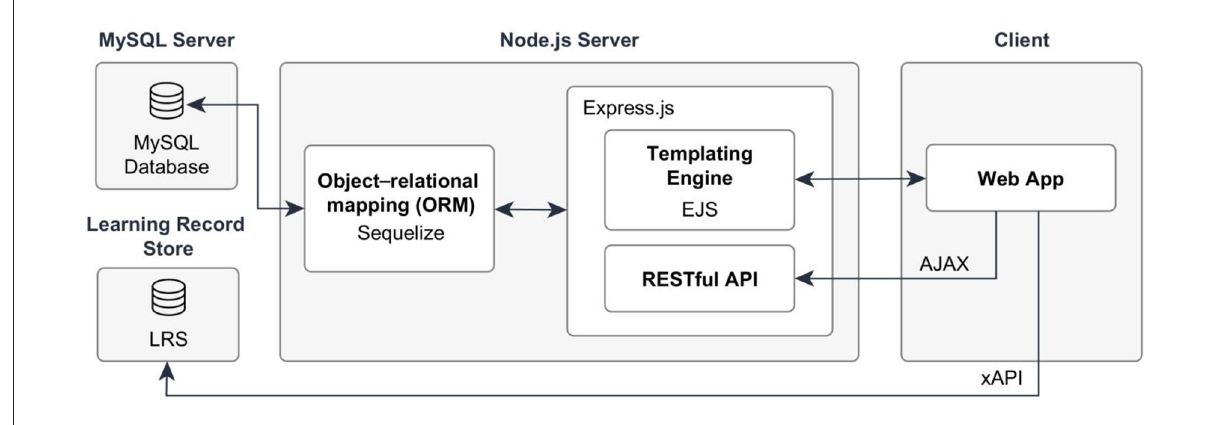
FIGURE9 A top-level view of the software